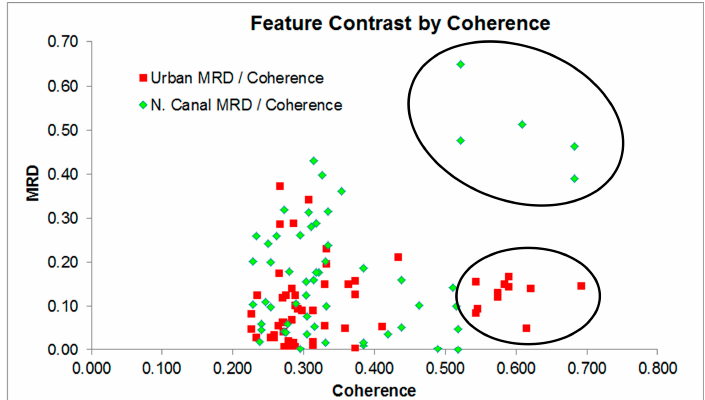
Figure 17. Graph showing contrast, quantified by means of MRD, of the two archaeological residues of the Northern Canal (in green) and the southern urban area (in red), plotted against their respective coherences. Where high coherence is observed, the contrast of the Northern Canal residue is often high, while the contrast of the southern urban area is consistently low. These patterns are shown in black ellipses.